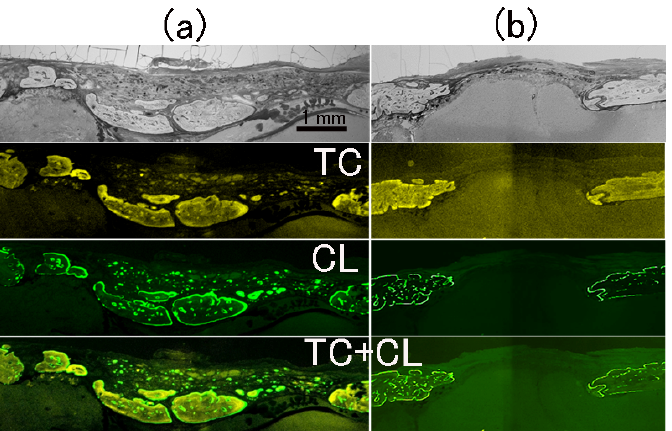
Figure 8. Double fluorescently stained images of cranial bone defect filled with P-nHAP/COL ( a ) and without implant material (DEF; ( b )) at 8 weeks after surgery. Top = contrast; second = TC, fluorescently labeled; third = CL, fluorescently labeled; bottom = TC + CL overlay images.